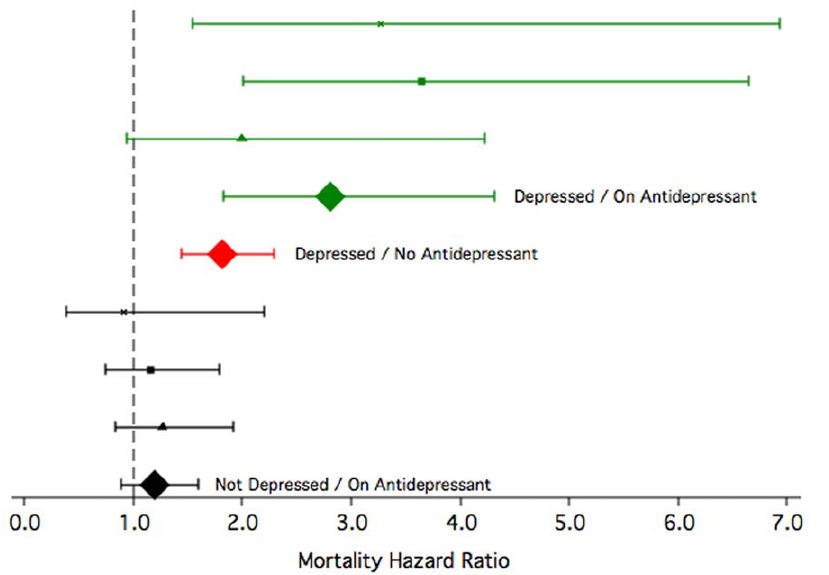
Figure 3. Mortality hazard of men without depression treated with antidepressants (n=247, black), men with depression not treated with antidepressants (n=245, red), and men with depression treated with antidepressants (n=52, green) (reference group: men with no depression not using antidepressants, n=4,732). The mortality hazard ratio associated with the use tricyclic antidepressants ( m ), selective serotonin inhibitors (SSRIs)( & ), other antidepressants (x) and all antidepressants combined ( X ) is shown in the figure. The whiskers represent the 95% confidence interval of the mortality hazard ratio. All analyses were adjusted for the demographic and lifestyle factors, as well as the comorbidities listed in table 1.